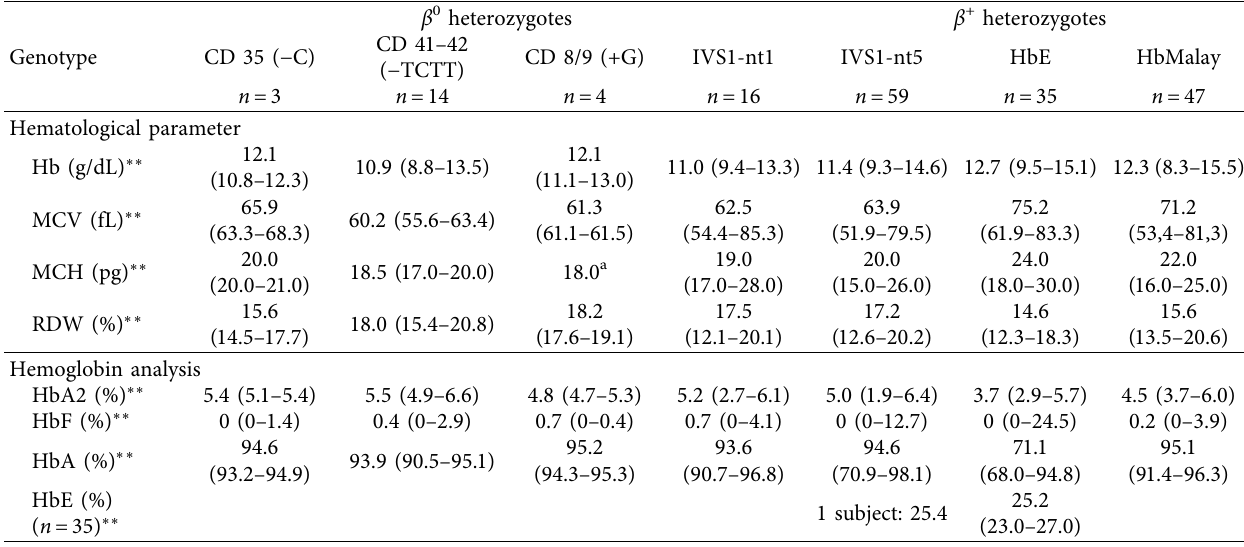
Table 4: Distribution of hematological parameters and Hb analysis for each